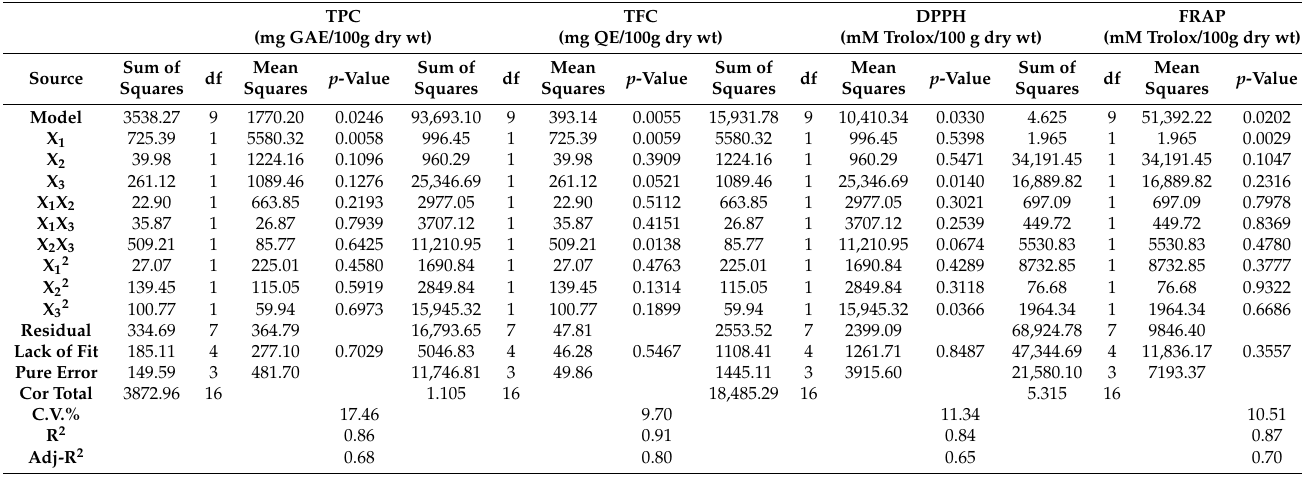
Table 3. Analysis of variance (ANOVA) for determination of optimization model